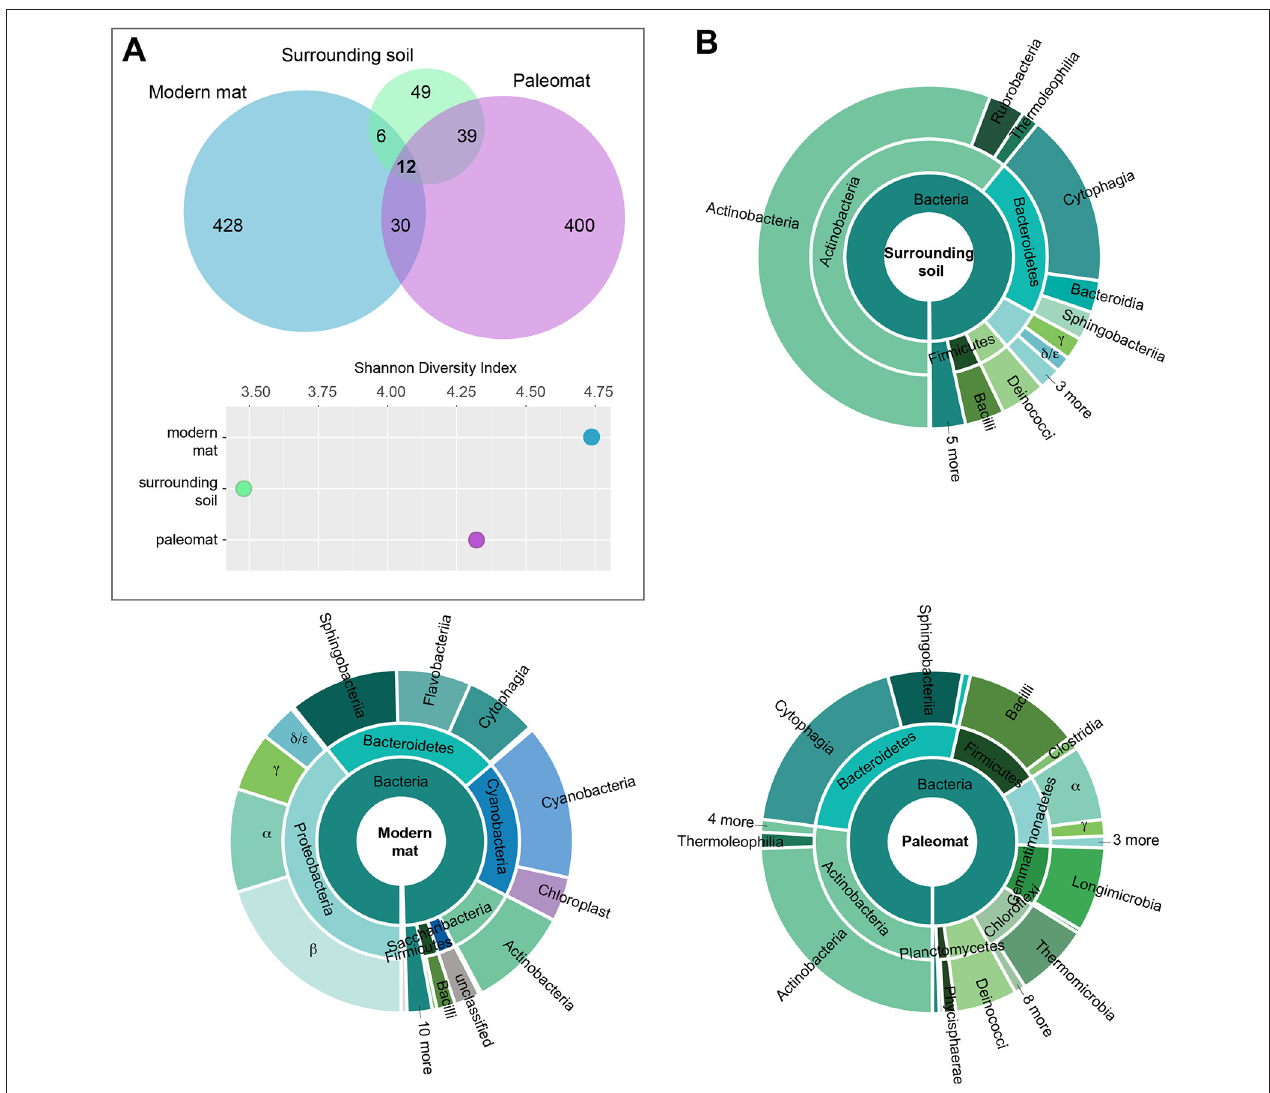
FIGURE 3 | Bacterial community composition of modern mat, paleomat, and soil surrounding the paleomat based on 16S rRNA gene Exact Sequence Variants (ESVs). (A) Top: ESV distribution among samples is indicated by the Venn diagram, with circles scaled according to the number of ESVs identified for the sample. Bottom: Shannon’s Diversity Index for each of the samples. (B) Taxonomic composition of ESVs in the 16S rRNA gene data from Lake Vanda modern mat, paleomat and soil surrounding the paleomat. Colors are the same